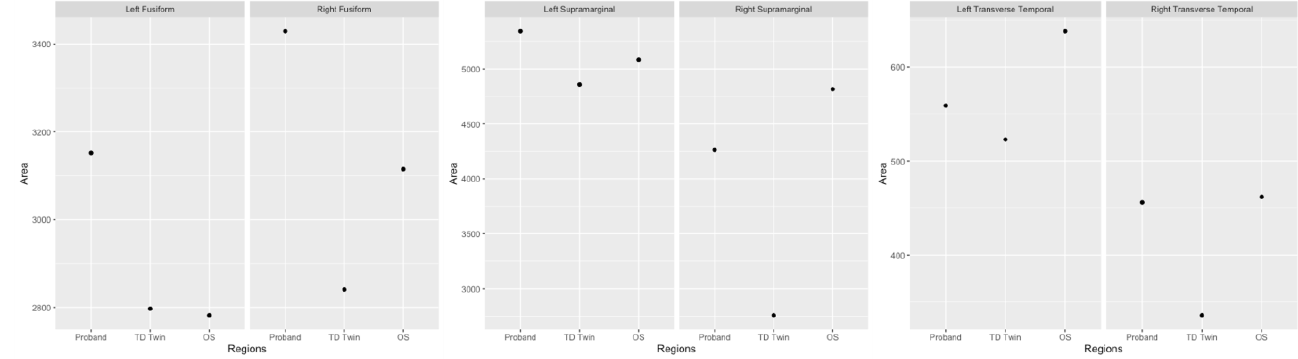
Figure 7. Q – Q plots of region of interest comparisons for regions in the ventral pathway. Examination of ROI comparison plots (Figure 7), determining the correspondence between the fusiform and inferior occipital gyrus in each sibling, suggests that the rela- tionship between the two structures is more similar for the typically developing twin and older sibling as compared to the sibling with reading disability. 3.5.2. Dorsal Pathway In Q – Q plots of ROIs in the dorsal temporo-parietal pathway, involved in phonolog- ical processing in reading, most regions had the greatest similarity between the twins (in- cluding the supramarginal gyrus, the planum temporale, and the transverse temporal gy- rus). However, for the superior temporal region, the siblings with reading disability tended to have more similar distributions of luminosity values (Figure 8). In the plots comparing regions of interest within each individual, for many of the comparisons, the relationships between structures were similar for each of the twins (the supmarginal/angular, supramarginal/transverse temporal, supramarginal/planum tem- porale, angular/superior temporal, angular/planum temporale, angular/planum polare, superior temporal/planum temporale, superior temporal/planum polare, transverse tem- poral/planum temporale, transverse temporal/planum polare, planum temporale/planum polare pairs). For the superior temporal/transverse temporal comparison, superior tem- poral/supramarginal, and angular/transverse temporal comparison, the siblings with reading disability tended to have more similarity between structures (Figure 9).